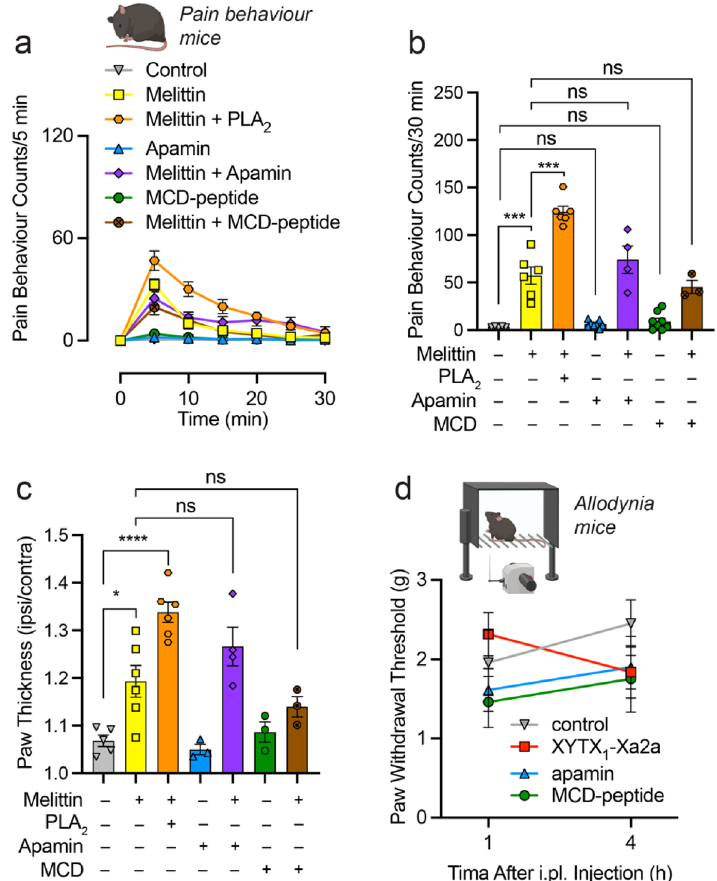
Figure 6. Pain-causing effects of A. mellifera venom components. ( a,b ) Shallow intraplantar injection of Melittin (200 pmol) caused spontaneous pain behaviours in mice which was potentiated by co-injection of venom PLA 2 (20 pmol), but not apamin (2 pmol) or MCD-peptide (2 pmol). Pain behaviour counts elicited by apamin (2 pmol) or MCD-peptide (2 pmol) were not different to control. Data are expressed as mean ± SEM ( n = 3–8). ( c ) Co-injection of melittin (200 pmol) plus venom PLA 2 (20 pmol) caused paw swelling. Data are expressed as mean ± SEM ( n = 3–8). Paw withdrawal thresholds measured by electronic Von Frey, 1 and 4 h after intraplantar injection of XYTX 2 -Xa2a (2 pmol), apamin (2 pmol) or MCD-peptide (2 pmol). *** P < 0.001 **** P < 0.0001; (one-way ANOVA with Tukey’s multiple comparison